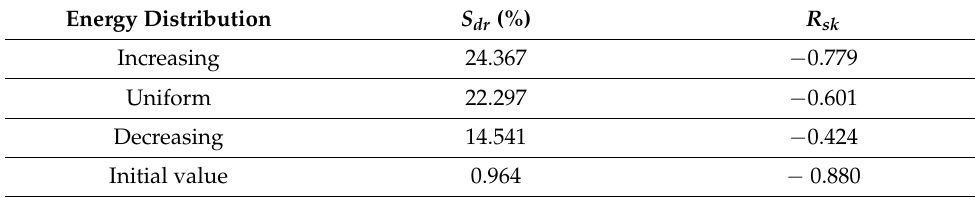
Table A9. S dr and R sk of steel.